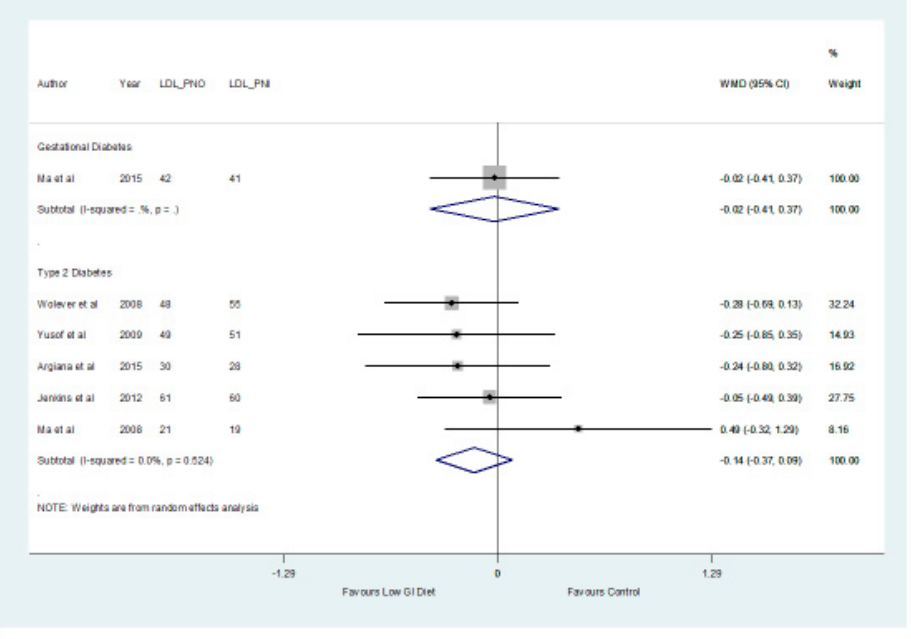
Figure 5. A forest plot showing the effect of a low GI diet on LDL cholesterol (mmol/L).